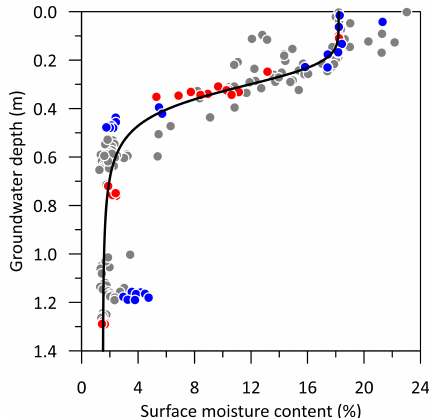
Figure 10. Groundwater depth h versus surface moisture content w s . The red dots are the measurements of 16 October, when the air temperature was rather high because of hurricane Ophelia (Figure 3a). The blue dots were obtained on 22 October in a light rain (Figure 3c). The line is the best-fit water retention curve, Equation (3). The total number of observations is